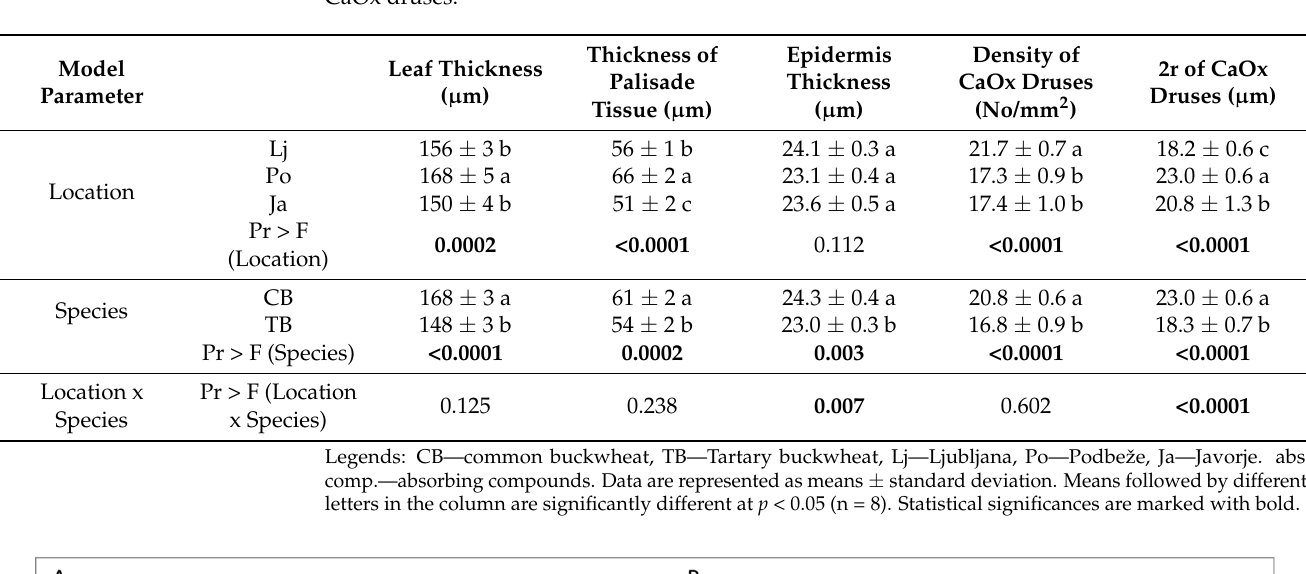
Table 3. Leaf thickness, palisade tissue thickness, epidermis thickness, number and diameter of CaOx druses.